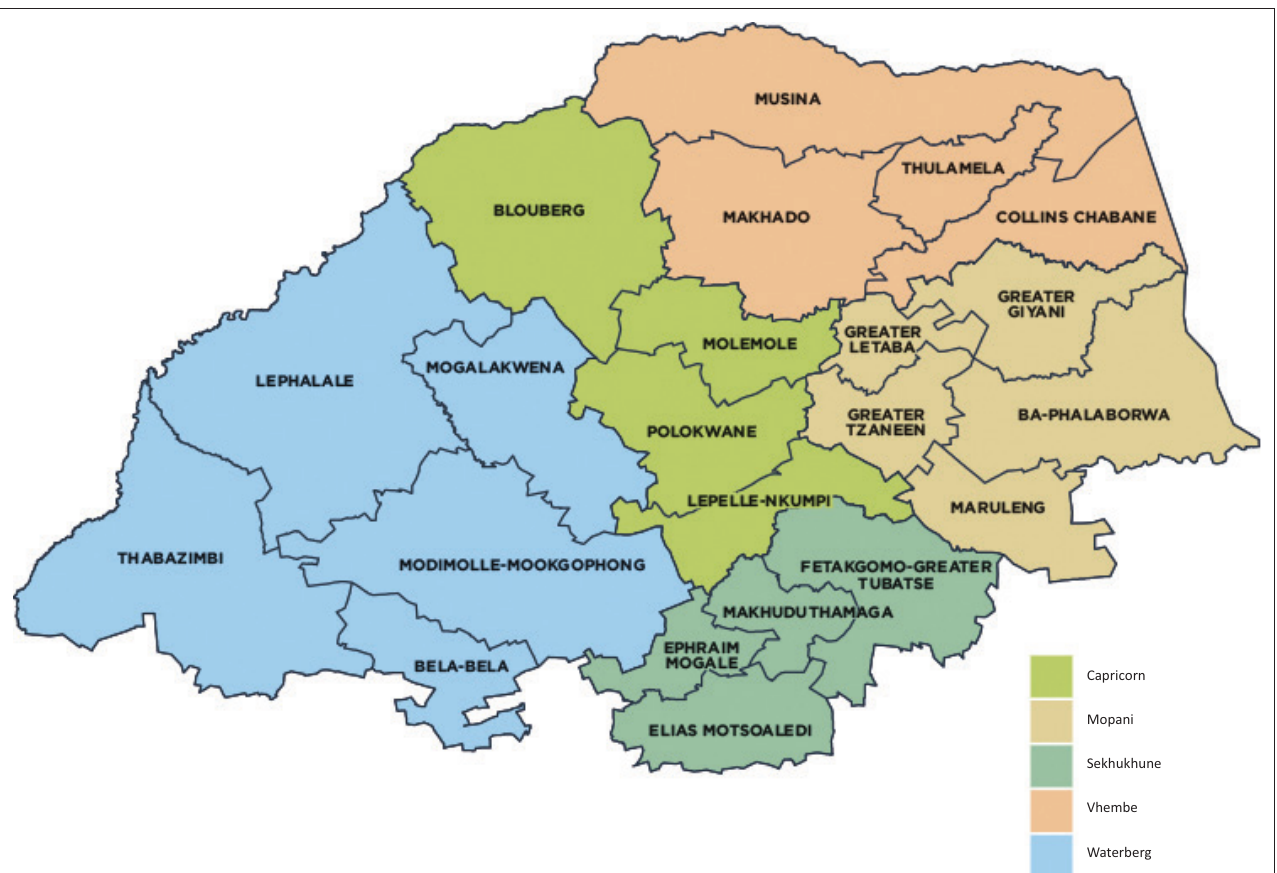
FIGURE 1: Map of